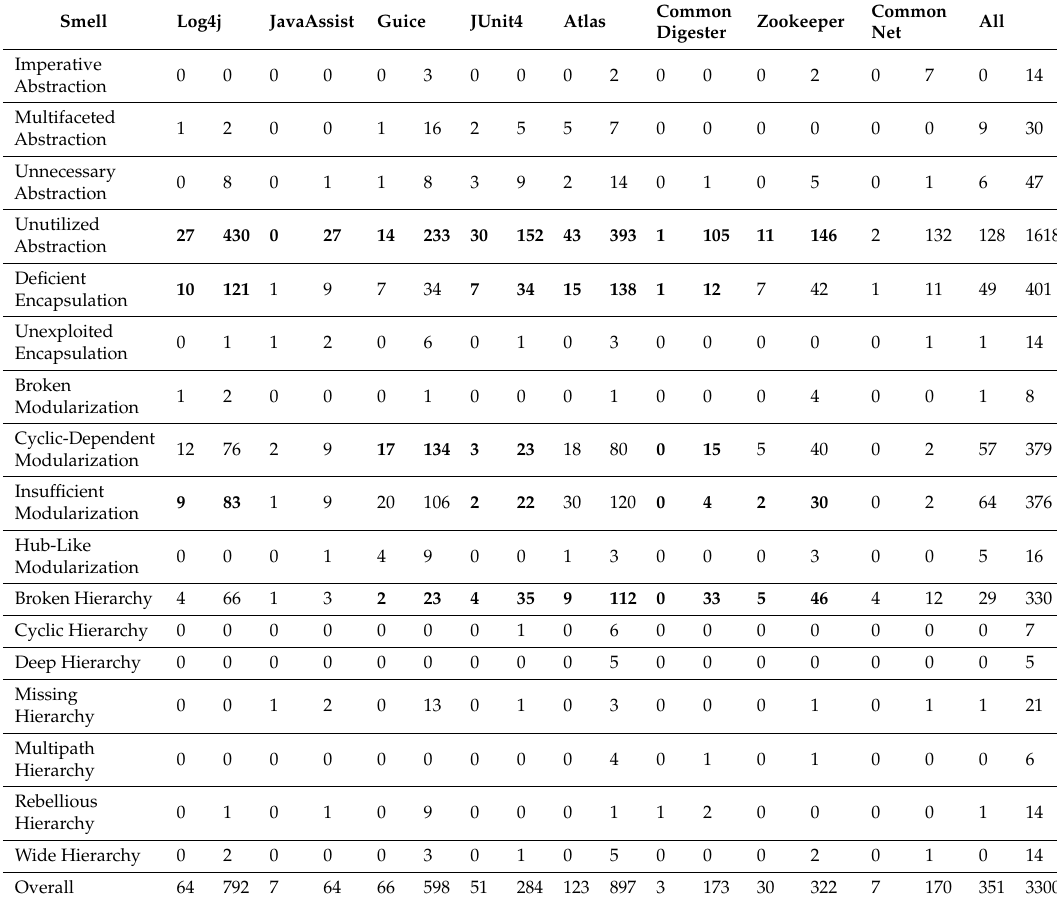
Table 7. Refactoring and smells removal